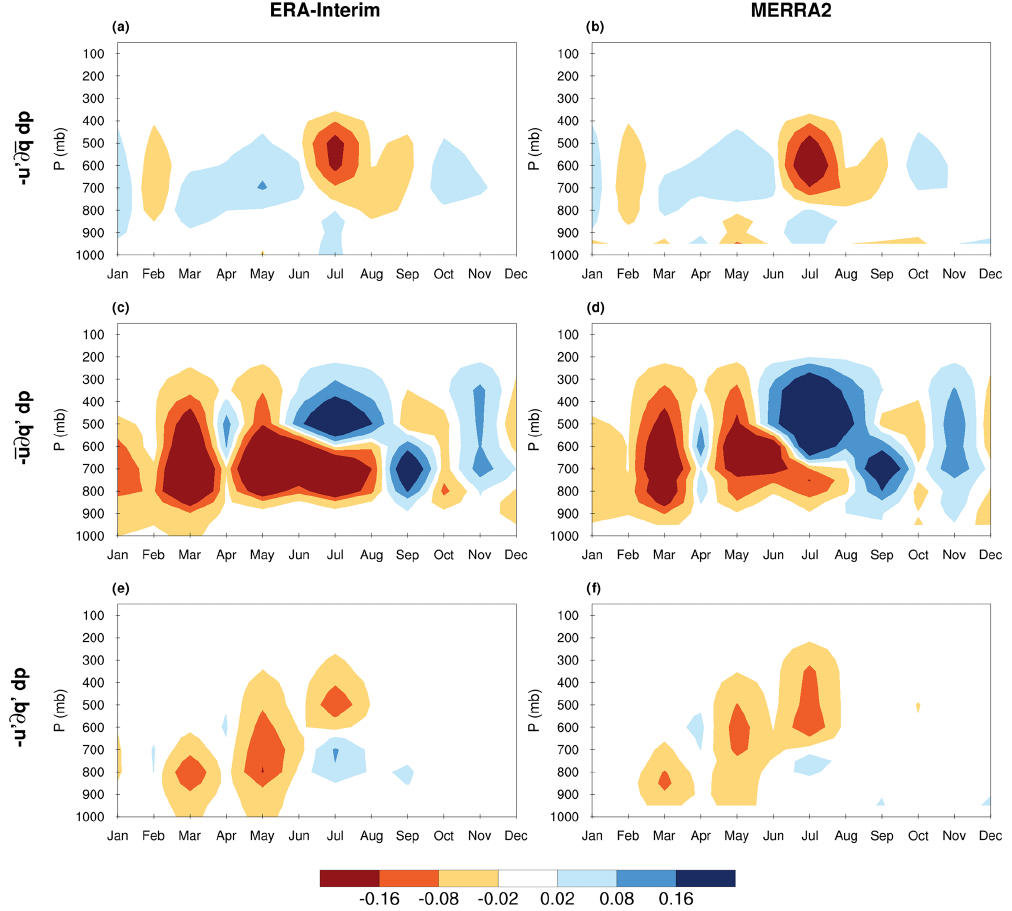
Figure 9. Same as Fig. 8 but for the NGP in